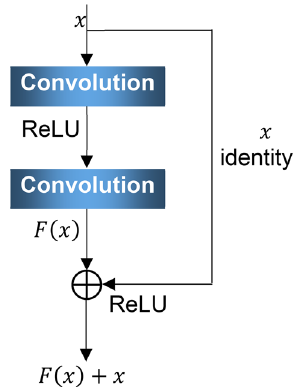
Figure 2. Structural diagram of residual block.